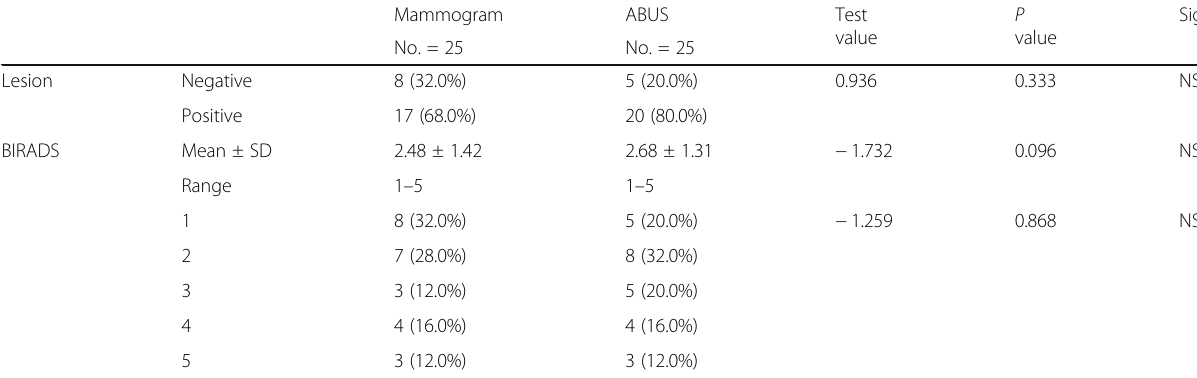
Table 5 Comparison between detected lesions and correlated BIRADS by mammogram and ABUS